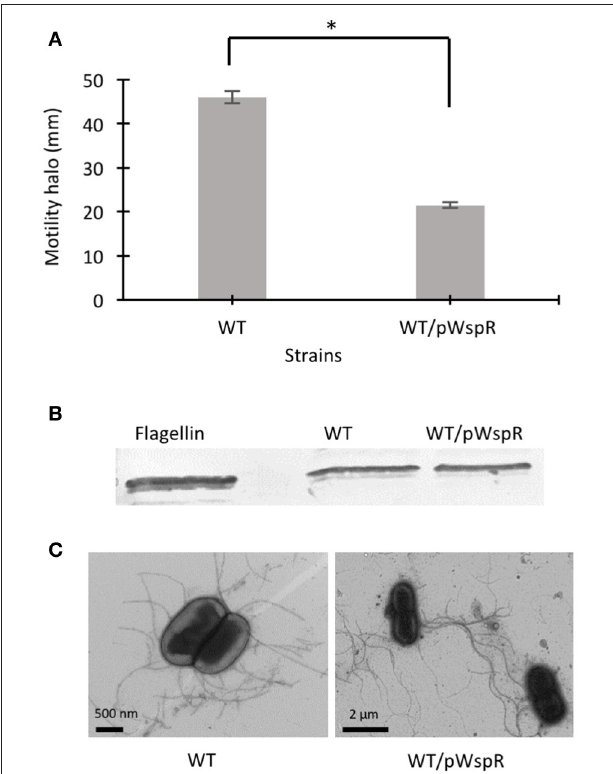
FIGURE 1 | The effect of c-di-GMP modulating conditions on swimming motility, flagellin expression, and flagella biosynthesis of B. cenocepacia K56-2 WT. (A) Motility of the strains was examined in semi-solid SCFM 0.3% agar plates after 24h at 37 ◦ C. Experiments were performed three-times independently in duplicate. *Denotes significant p -values ( p < 0.01). (B) Whole cell lysates were used to separate proteins by 12% SDS-PAGE followed by detection of flagellin protein using anti-flagellin primary antibody and alkaline phosphatase crosslinked to secondary antibody. From two Western blots, one representative experiment is shown. (C) Electron micrographs of uranyl acetate stained WT strains displaying flagella under c-di-GMP varying conditions.